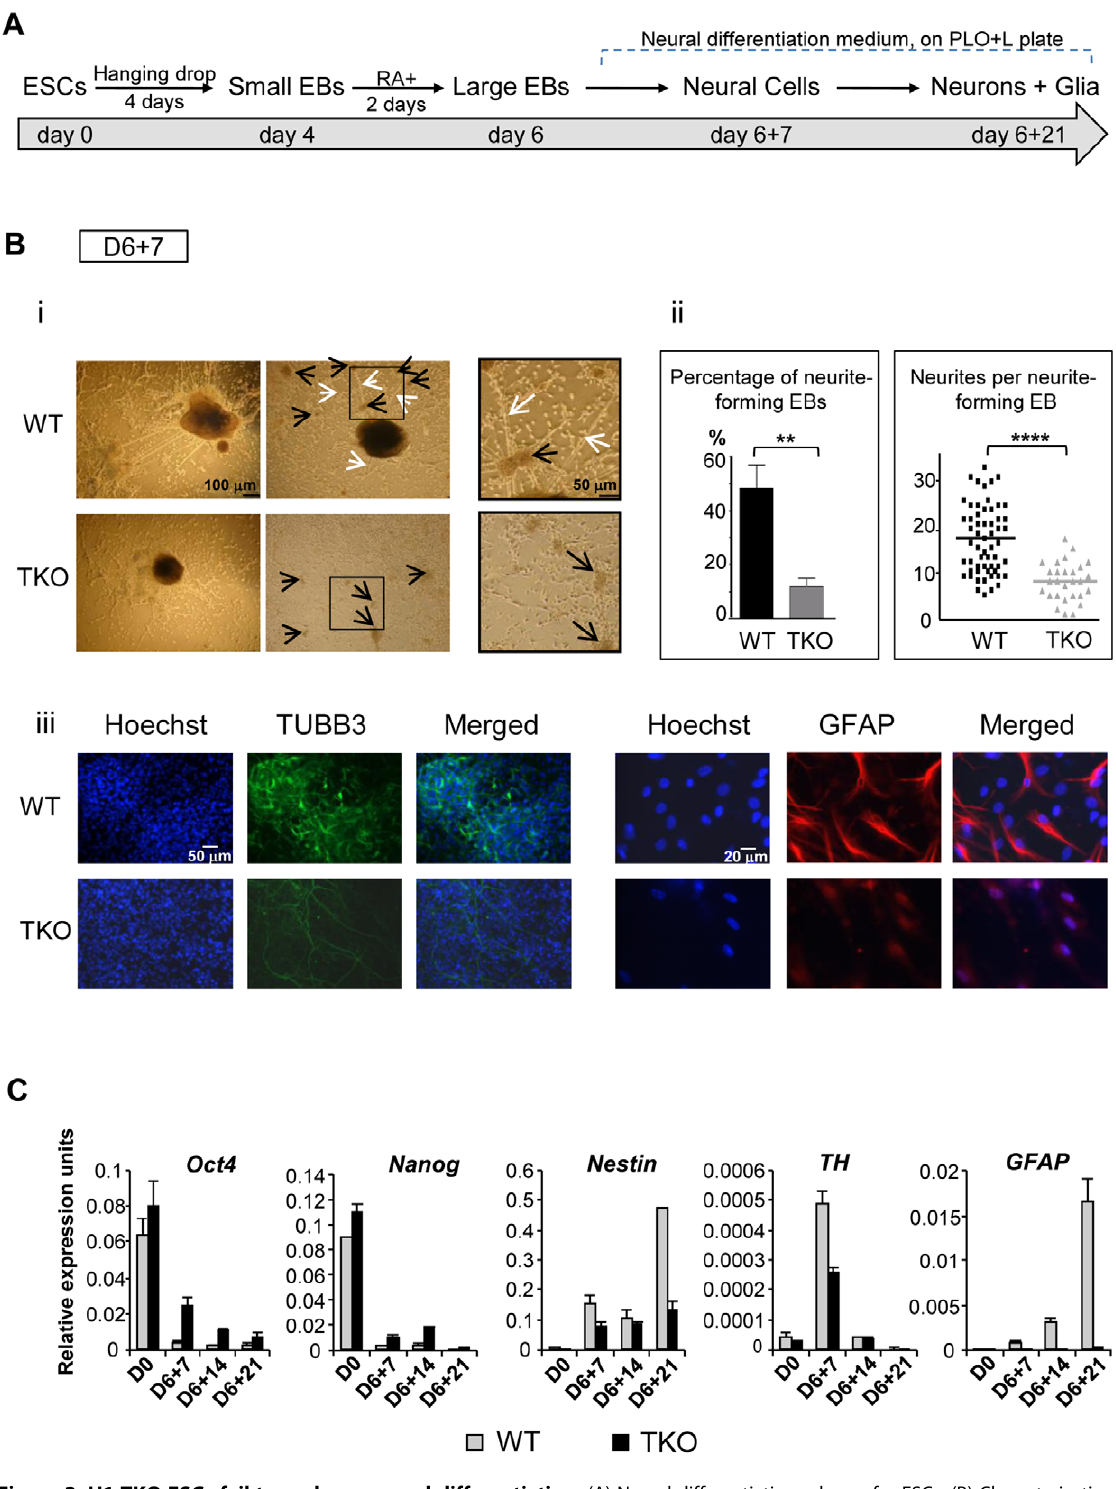
Figure 3. H1 TKO ESCs fail to undergo neural differentiation. (A) Neural differentiation scheme for ESCs. (B) Characterization of WT and H1 TKO cultures on day 6 + 7 under neural differentiation protocol. i). Phase contrast images shows that H1 TKO mutants were unable to adequately form neurites and neural networks. Right panels: zoom-in images of the areas encircled with black rectangles. Scale bar: 100 m m (left panels) and 50 m m (right panels). ii). Left panel: Percentage of neurite-forming EBs. Numbers were averaged from 6 experiments. 80 EBs were counted per experiment. Right panel: Numbers of neurites per neurite-forming EB. Number of neurites was counted from EBs that produced neurites. 58 and 28 neurite- forming EBs from respective WT and TKO were selected and counted for neurite numbers. **: P , 0.01; ****: P , 0.0001. iii). Immunostaining for expression of TUBB3 and GFAP. Nuclei were stained with Hoechst 33342. Scale bars: 50 m m (left panels) and 20 m m (right panels). Results are representative of three independent experiments. (C) H1 TKO ESCs were unable to adequately repress the pluripotency genes and to efficiently induce the expression of neural genes. Expression levels of pluripotency genes ( Oct4 and Nanog ), neural marker ( Nestin ), neuronal marker ( Tyrosine